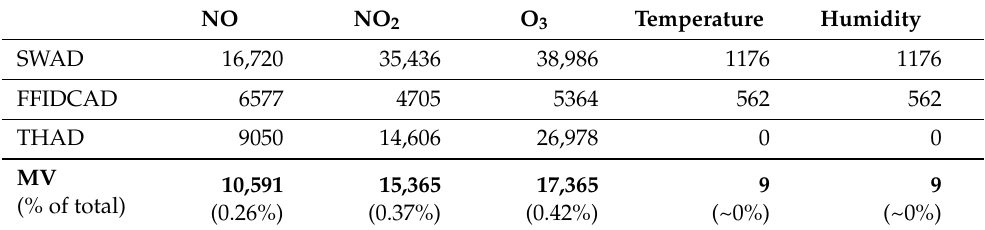
Table 1. Anomalies detected by SWAD, FFIDCAD, and